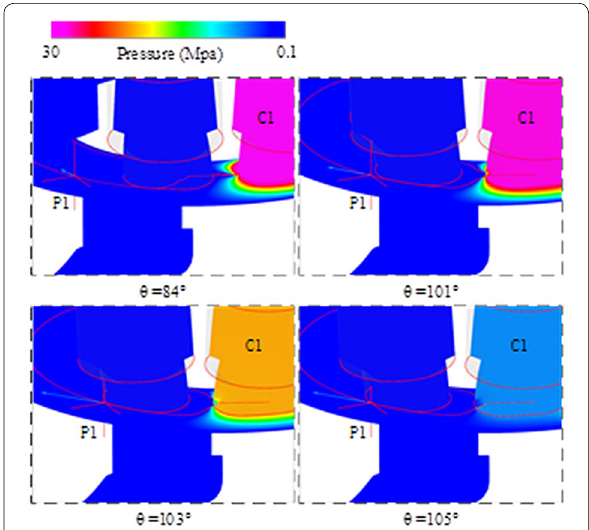
Fig. 5 Evolution of pressure cloud diagram on cross section I and spherical oil film